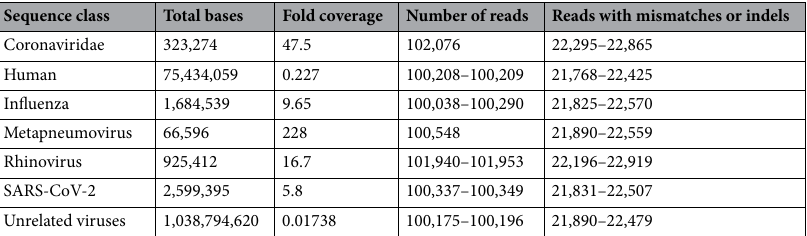
Table 4. Summary of benchmark datasets.